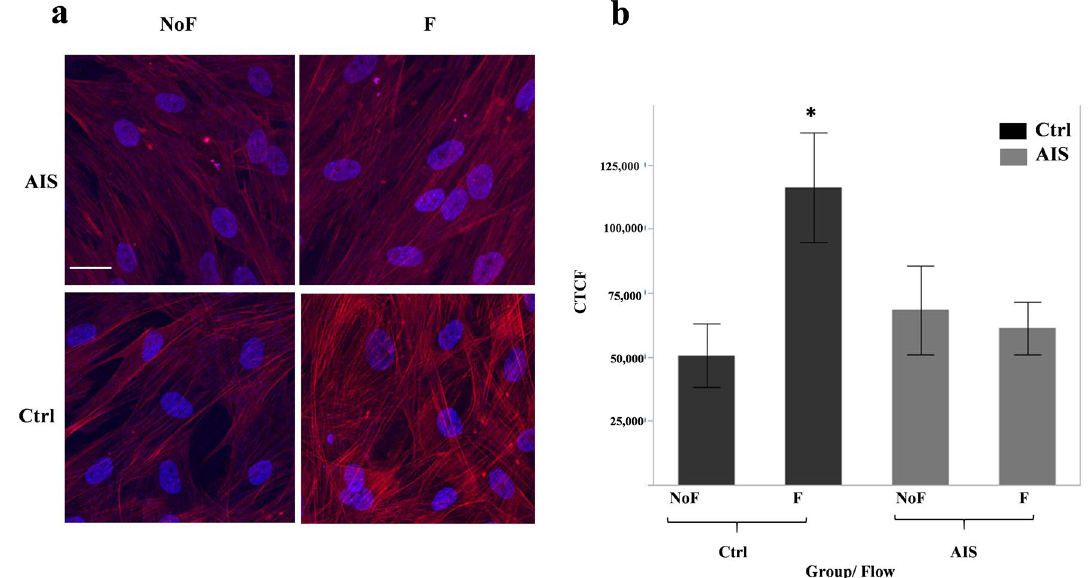
Figure 2. Flow induces actin rearrangement in control osteoblasts but not AIS. ( a ) Immunofluorescence micrographs of AIS and control primary osteoblast cells after 20 h of fluid flow application in comparison to their static counterparts. F-Actin is stained with Phalloidin (red) and nucleus with Hoescht (blue). White scale bar, 25 µm. ( b ) Data represents the mean ± SEM of corrected total cell fluorescence (CTFC) which have been measured using Image-J software at 5 fields of view per sample (20 per group) and normalized to the background of each sample. n = 4 per group, Statistical significance was determined by Student T-test using